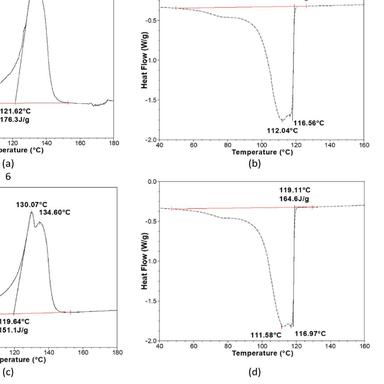
DSC curve of irradiated HDPE with both heating/cooling cycles: (a,c) evaluation of the melting temperature and enthalpy respectively during the first and second heating cycles; (b,d) evaluation of the crystallization temperature and enthalpy respectively during the first and second cooling cycles.